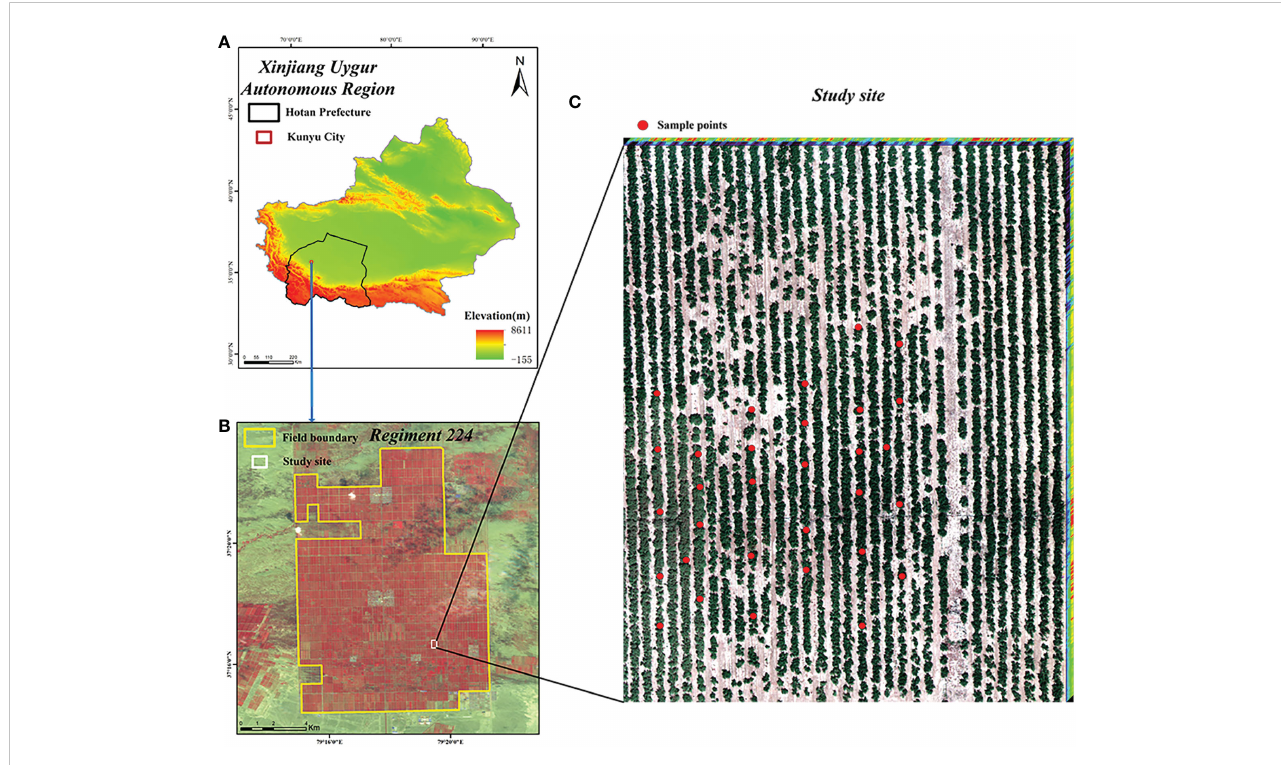
FIGURE 1 Location of the study site. (A) Xinjiang Uygur Autonomous; (B) Regiment 224; (C) Study